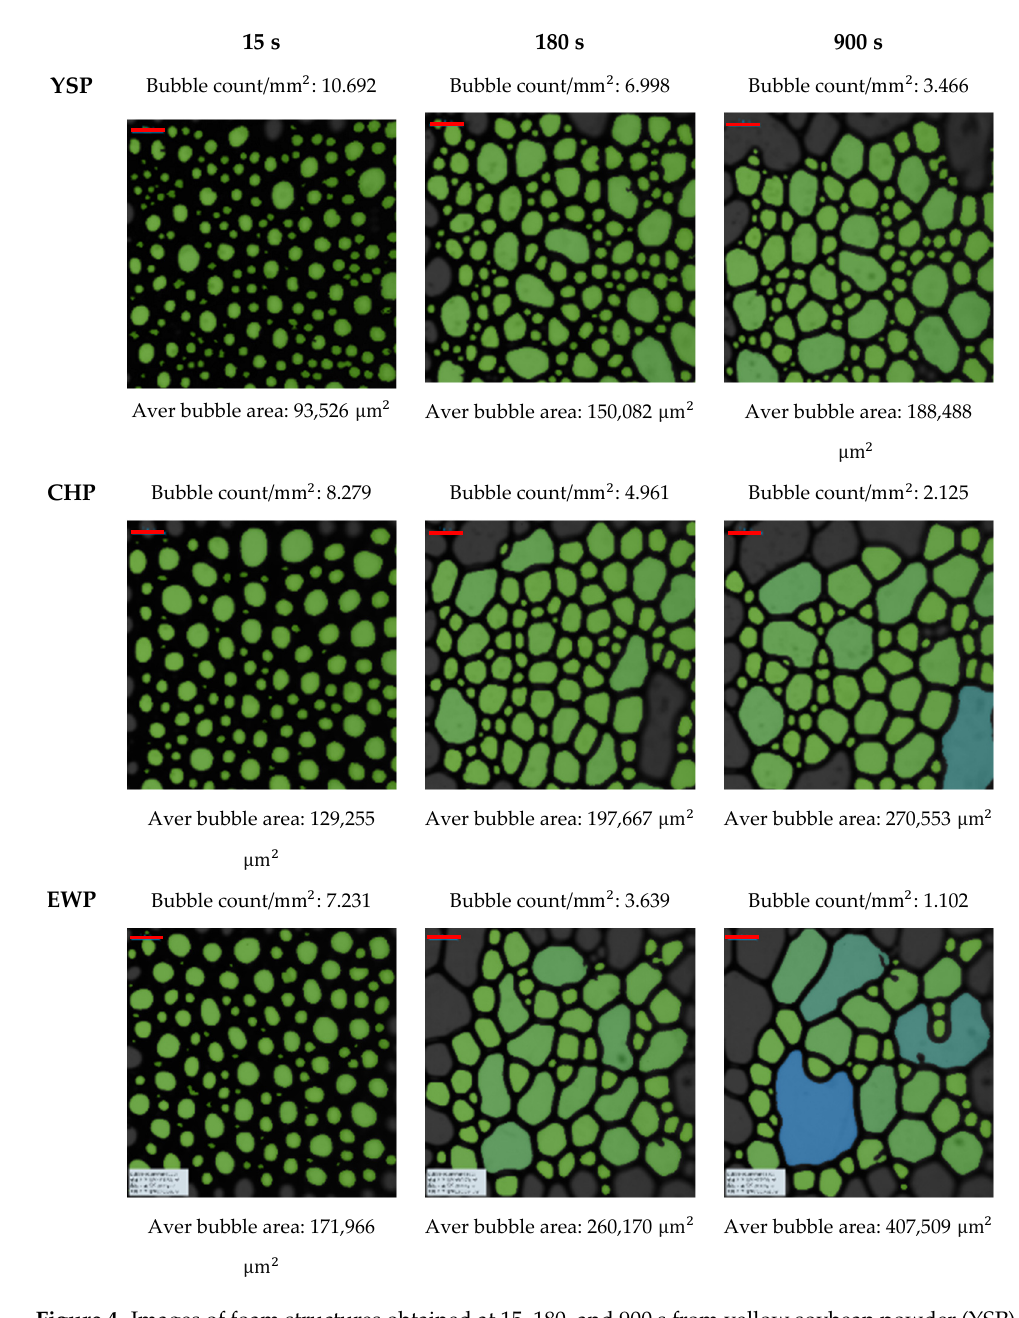
Figure 4. Images of foam structures obtained at 15, 180, and 900 s from yellow soybean powder (YSP), chickpea powder (CHP), and egg white powder (EWP). The red bar at the top of each image means a scale bar, and represents 1 mm.